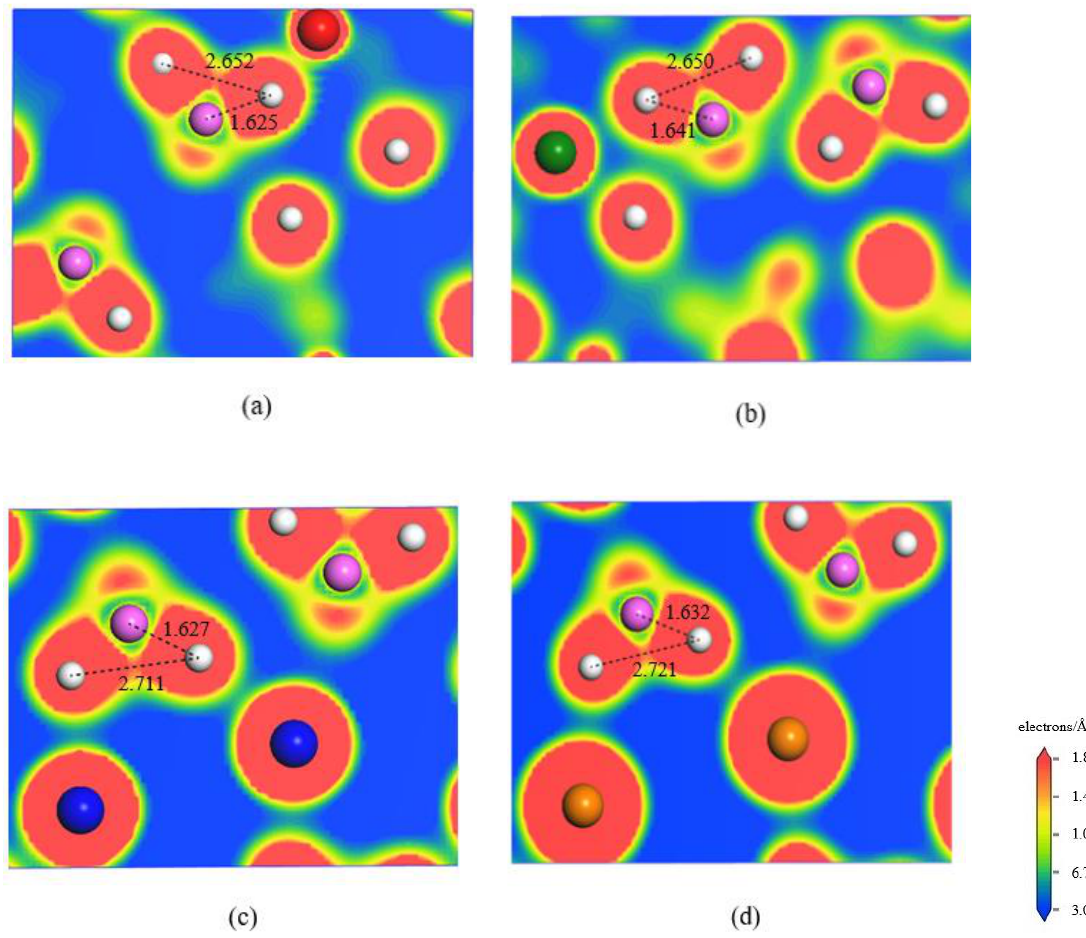
Figure 5. The electronic density contours for MAlH 4 (M = Li, Na, K, and Cs) with the contour line from 0.03 to 0.18 electrons/Å 3 : ( a ) LiAlH 4 , ( b ) NaAlH 4 , ( c ) KAlH 4 , and ( d ) CsAlH 4 . Li, Na, K, Cs, Al, and H atoms are denoted by red, green, blue, orange, pink, and white spheres, respectively. The shortest distances between Al and H atoms and H and H atoms in this figure are described (in Å). Table 3. The Mulliken population for MAlH 4 (M = Li, Na, K, and Cs), including the average bond order (BO), average bond length (BL), and scaled bond order (BO s ) between Al-H and H-H. Al-H Compounds